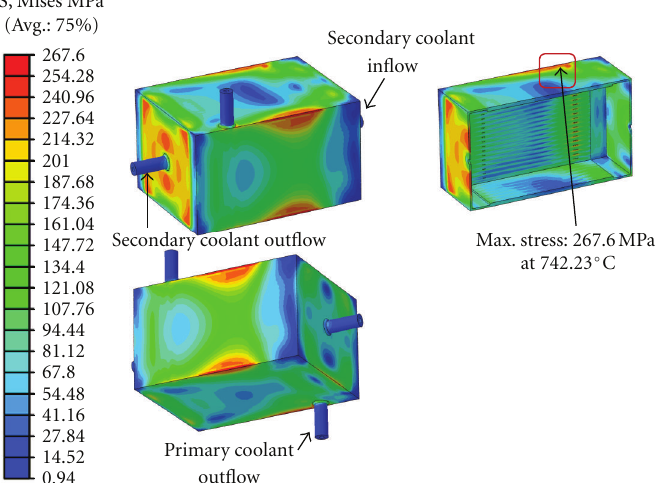
Figure 17: Overall stress contours of a 10kW class PHE prototype from an elastic-plastic analysis using the weld material